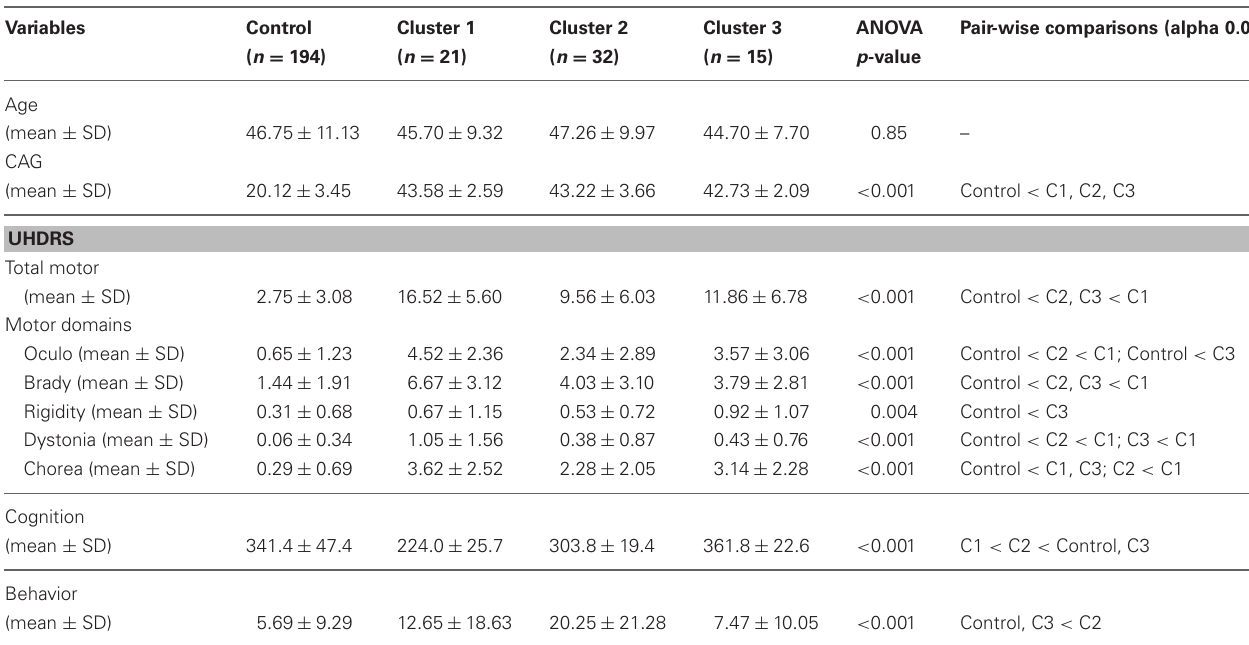
Table 4 | Group comparisons between